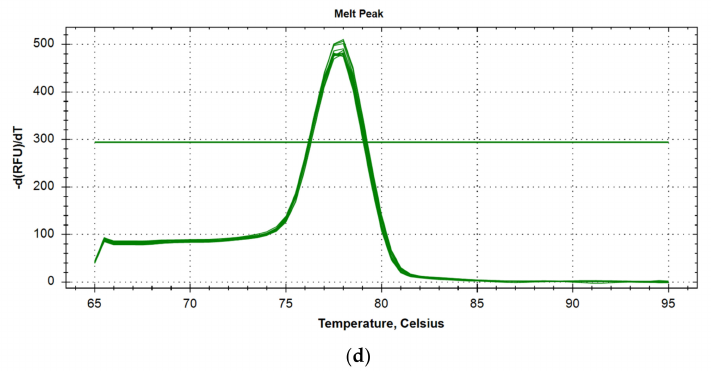
Figure 2. ( a ) Melt curve plot for AIRE cDNA amplicons. ( b ) Melt curve plot for GCG cDNA amplicons. ( c ) Melt curve plot for INS cDNA amplicons. ( d ) Melt curve plot for TFF3 cDNA amplicons. Melt curve plots for AIRE , GCG , INS and TFF3 cDNA amplicons.